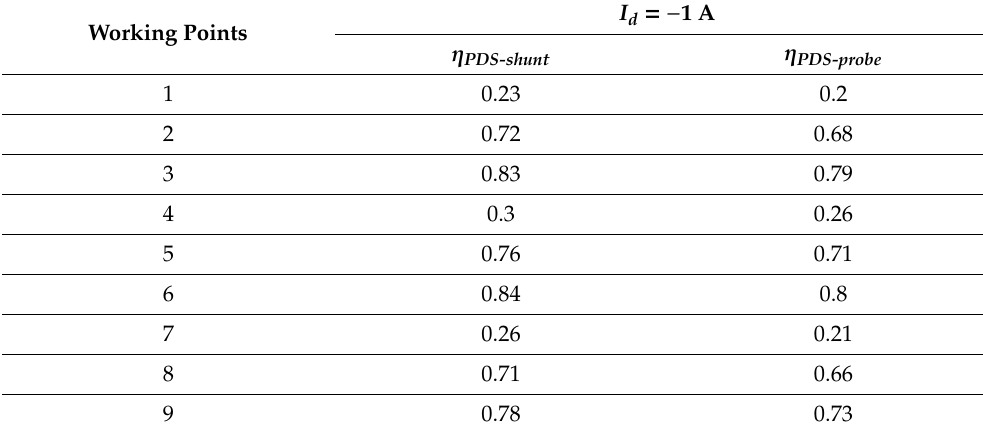
Table 11. E ffi ciency detected for each working point at I d = − 1 Table 11. Efficiency detected for each working point at I d = −1 A.